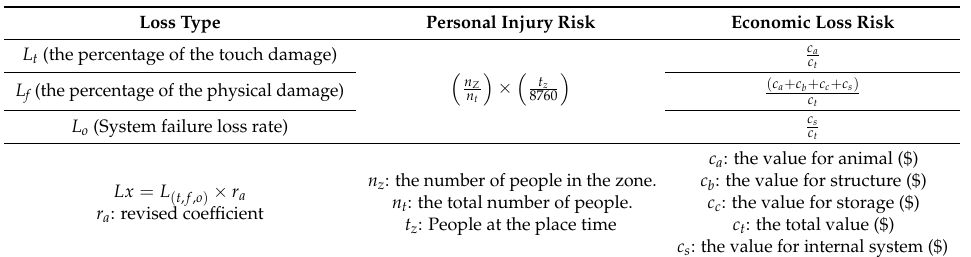
Table 2. The comparison of the rate of loss for R1 and